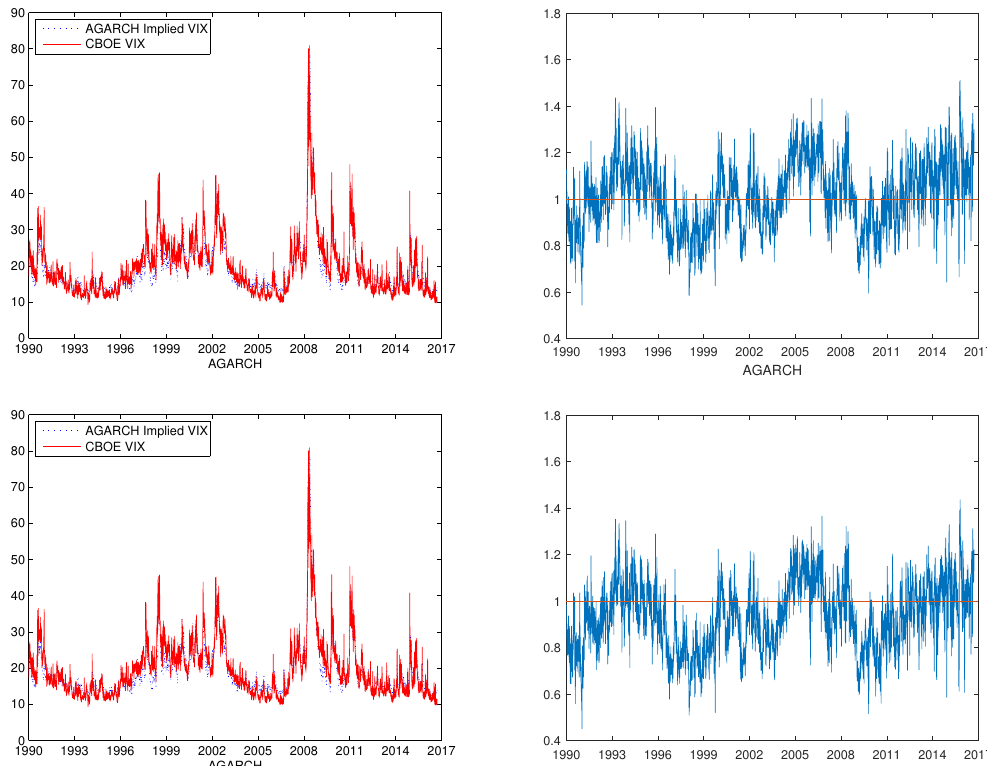
Figure 6. Comparison between CBOE VIX and implied VIX of the AGARCH(1,1) model using both returns and VIX data with the upper panel showing the result under the mLRNVR and the lower panel showing the result under the LRNVR. The left panels show the index values of CBOE VIX and implied VIX and the right panels show the ratio of the implied VIX to CBOE VIX and a horizontal line at 1 for reference.